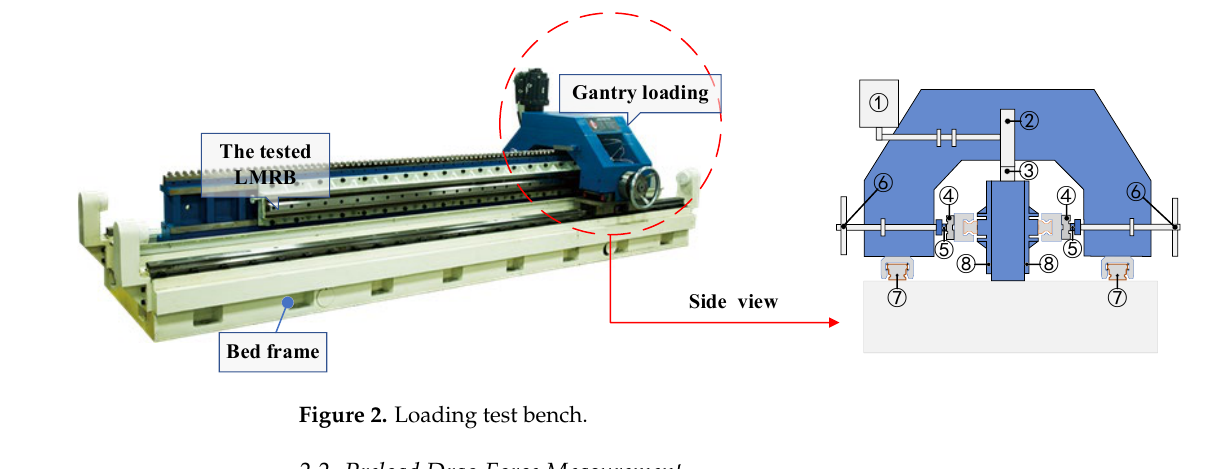
Figure 2. Loading test bench.